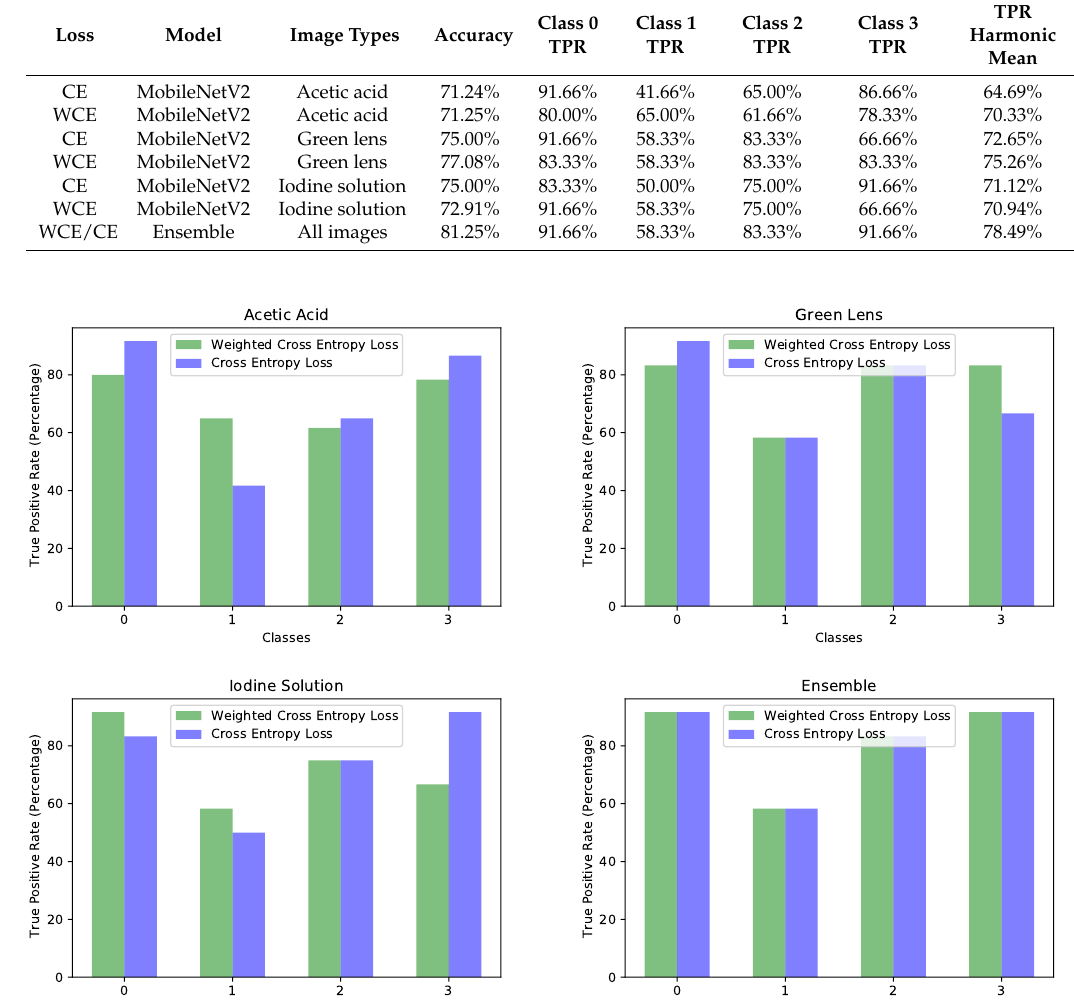
Figure 9. Per-class true positive rate comparison between models trained with cross entropy and with weighted cross entropy. Each plot displays the result for a different type of image, except for the ensemble, which takes advantage of all image types at once. These plots are a visualization of the data from Table 10, and the same training procedures and models are